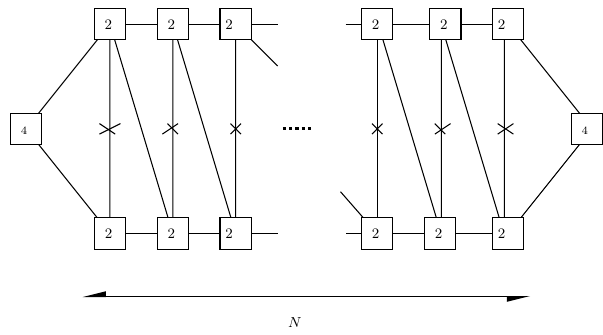
Figure 11. The tube with SU(2) N , a(cid:14)ne, maximal punctures. The crosses on the lines denote chiral (cid:12)elds (cid:13)ipping baryonic operators as in (cid:12)gure 3. is even and when N is odd. For N even some of the rank of the symmetry is